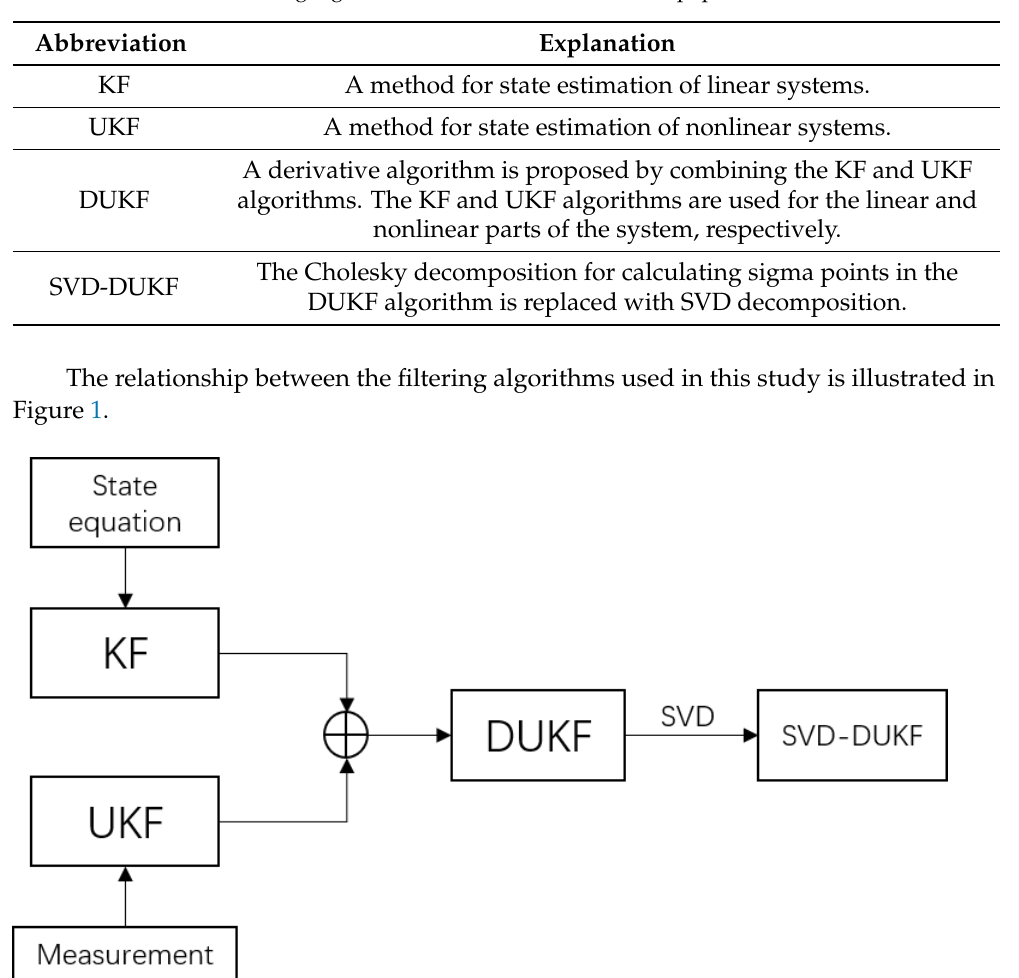
Table 1. Definition of filtering algorithm abbreviations used in this paper.